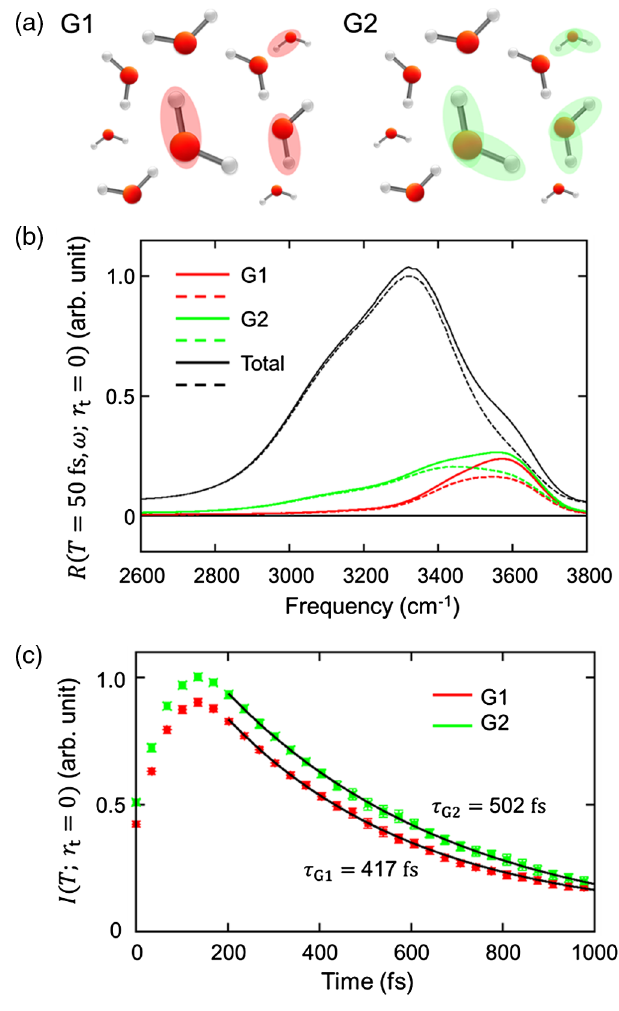
FIG. 3. Schemes to disentangle the effects of intramolecular and intermolecular energy transfer on spectral diffusion. (a) Sche- matic pictures of the G1 and G2 subgroups of the O-H chromophores. The rest of the O-H chromophores are assigned to the G 1 0 and G 2 0 subgroups, respectively. (b) Fourier- transformed VCF spectra for the RNEMD (solid line) and EMD (dashed line) at time T ¼ 50 fs for the G1 and G2 subgroups. For comparison, the VCF spectra for all O-H chromophores are also plotted (Total). (c) Time dependence of the excess VCF intensities for the G1 and G2